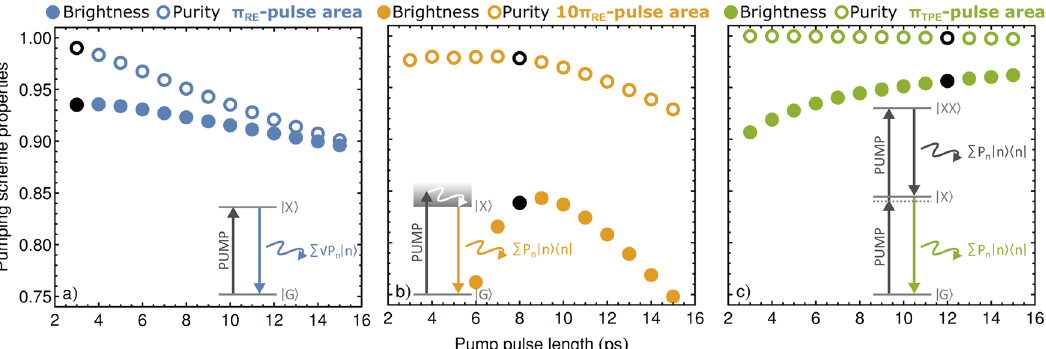
Fig. 1 Simulation of emission properties under different pumping schemes. Simulated brightness and single-photon purity for individual pumping schemes calculated from our numerical model (see Methods) for ( a ) resonant excitation (RE) between ground G j i and exciton X j i states, ( b ) longitudinal phonon-assisted excitation (LA) ( c ) two-photon excitation (TPE) between ground G j i and biexciton XX j i states. Insets show a schematic representation of each pumping scheme (the upper grey area in the LA sketch represents the vibrational quasi-continuum of the exciton state). Optimal FWHM pulse lengths are marked with black disks and circles, chosen pulse areas for maximum population inversion are π RE for RE and π TPE for TPE, while we choose 10 π RE for LA. Simulation parameters are: dot-cavity coupling (cid:1) hg ¼ 50 μ eV , radiative decay rate (cid:1) h γ = 0.66 μ eV, cavity loss rate (cid:1) h κ = 379 μ eV (yielding a Purcell factor of P = 10), initial system temperature T = 4.2K, electron con fi nement length 3 nm, and material properties typical for GaAs. Throughout the paper, we assume that photonic states are maximally pure P ffiffiffiffiffi p 1 p n n j i , while they are expressed as diagonal states for LA and TPE, i.e. as P in the photon-number basis for RE, i.e. expressed as n ¼ 0 1 p n n j i n h j n ¼ 0